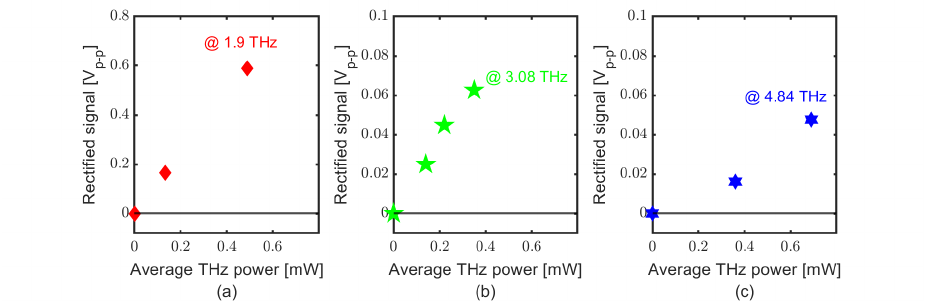
Figure 7. SD THz detector response with FELBE at different frequencies and power using the oscilloscope, ( a ) at 1.9 THz, ( b ) at 3.08 THz and ( c ) at 4.84